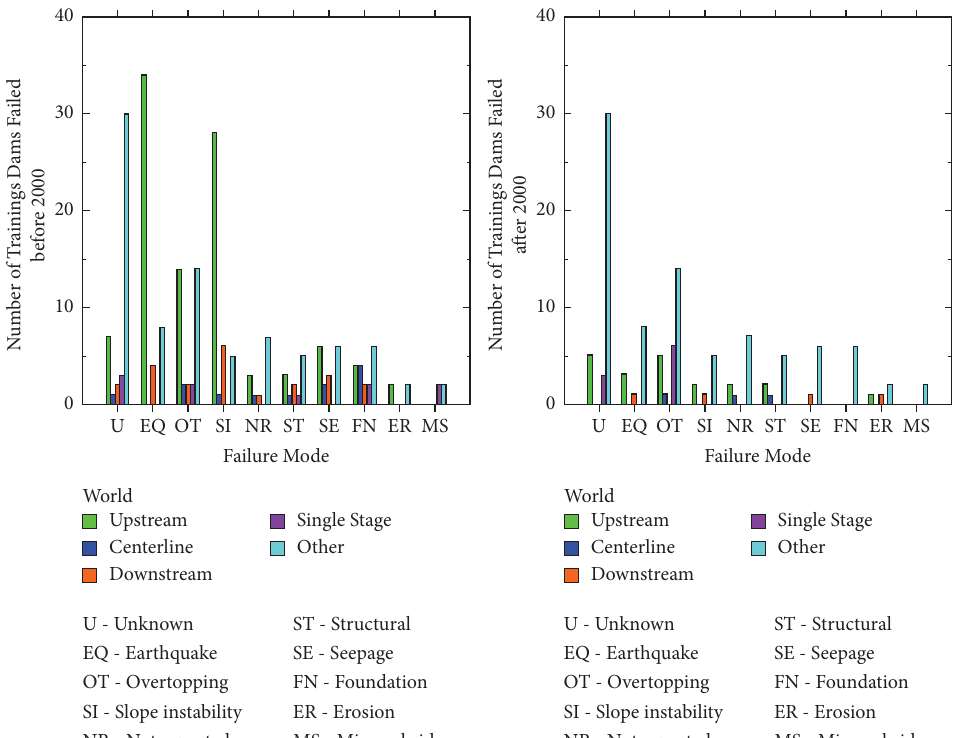
Figure 13: Number of tailings dams failed per failure mode in the world, according to dam type, before and after 2000 (data from Bowker [22] and Torrez-Cruz